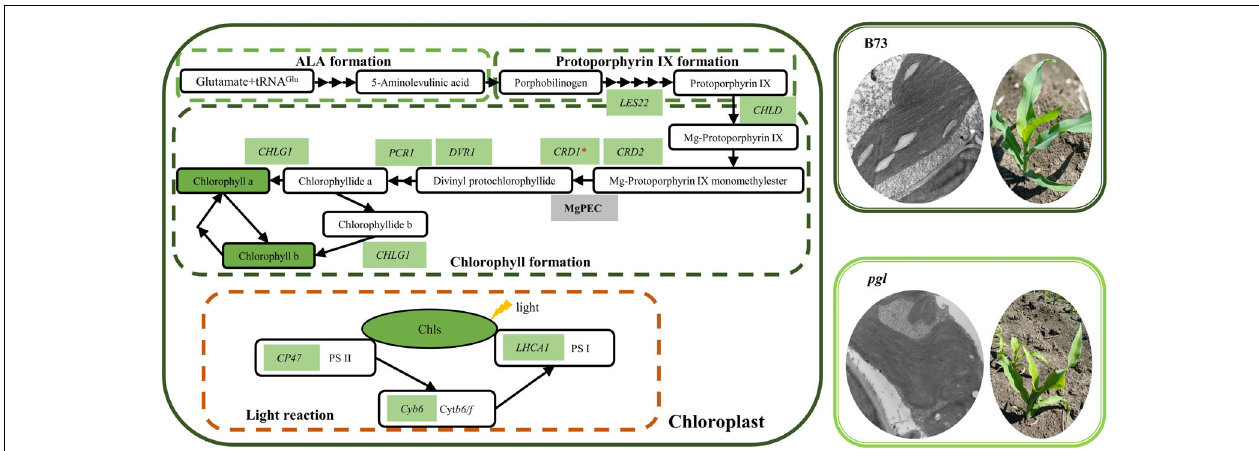
FIGURE 8 | The model of chlorophyll biosynthesis and light reaction of photosynthesis in pgl . The chlorophyll biosynthesis pathway mainly consists of three parts (ALA formation, protoporphyrin IX formation and chlorophyll formation). Most genes and metabolites showed down-regulated expression in the pgl mutant compared to the wild-type plant (B73) resulting in decreased chlorophyll contents, abnormal chloroplast development and perturbed photosynthesis. The green background represents decreased expression of genes or metabolites in the pgl mutant. These genes are labeled on the basis of qRT-PCR analysis and are involved in chlorophyll biosynthesis and the light reaction of